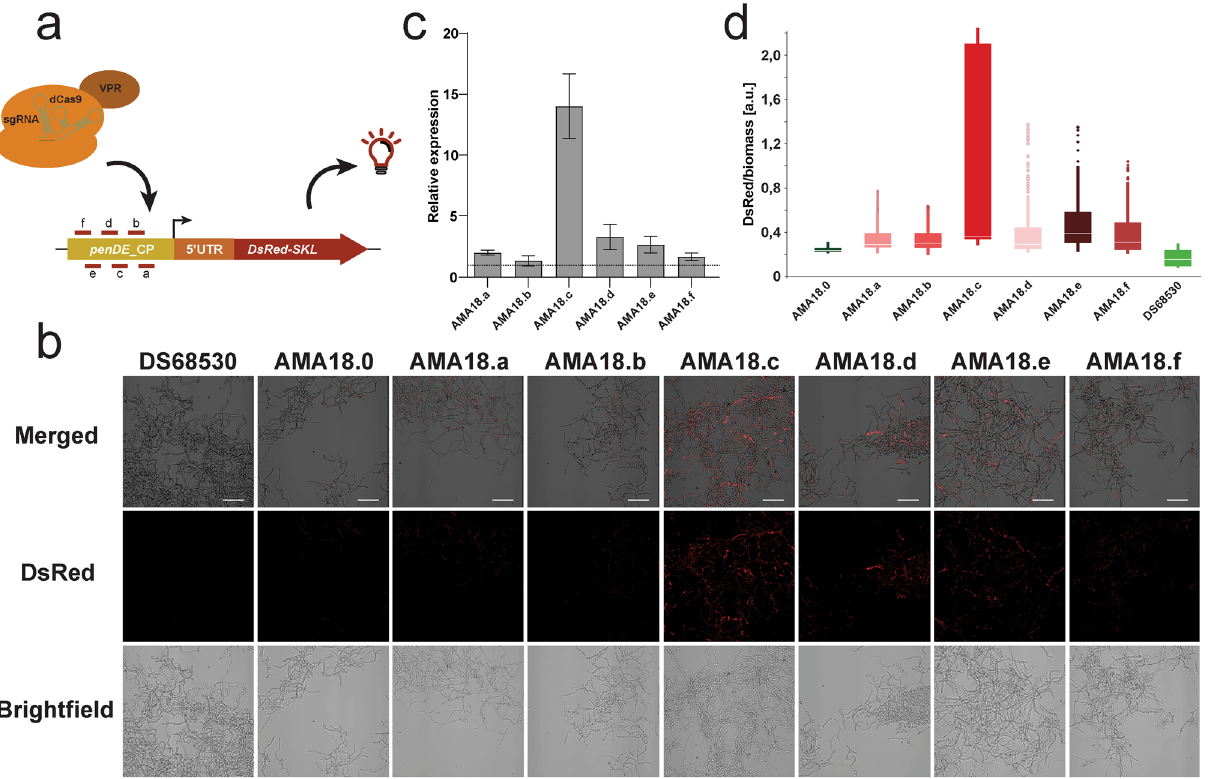
Figure 2. CRISPRa (dCas9-VPR) based activation of penDE -CP_ DsRed . ( a ) Schematic representation of the penDE -CP upstream DsRed . The transcription start site (TSS) is indicated as a black arrow, short lines with letters indicate targeting sites of the sgRNAs. ( b ) Confocal fluorescence microscopy imaging of DsRed targeting CRISPRa strains and controls with no-sgRNA (AMA18.0) and without the penDE -CP_ DsRed transcription unit (DS68530). Strains were grown for 5 days in liquid SMP media. Scale bars represent 50 μm. ( c ) qPCR analysis showing expression levels of DsRed in CRISPRa strains relative to strain carrying pAMA18.0 no-sgRNA negative control (dotted line) after 5 days of growth in SMP. ( d ) Development of DsRed/biomass over time during time window of 0–40 h cultivation in the BioLector system. Data were obtained from 3 separate experiments, each consisting of 2–3 biological replicates; error bars show the standard Fig. S3). The strength of DsRed activation by different sgRNAs was determined relative to biomass to avoid variance caused by small differences in growth. During the time interval of 0–40 h, DsRed/biomass values in CRISPRa strains were measured and compared to negative control strain carrying pAMA18.0 and the back- ground fluorescence of the DS68530 parental strain. The pAMA18.c carrying strain showed the highest level of relative fluorescence and thus provided the most efficient activation compared to the non-sgRNA negative control (Fig. 2d). All other CRISPRa strains show activation of penDE -CP_ DsRed , with weakest activation in strains carrying pAMA18.a and pAMA18.b vectors.